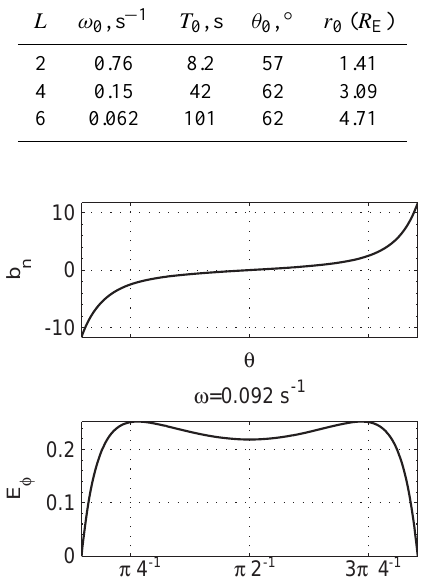
Figure 8. Wave forms (arbitrary unit) of the fundamental mode ( L = 5) for the poloidal standing Alfvén mode of the dipole field. Format is the same as Fig.